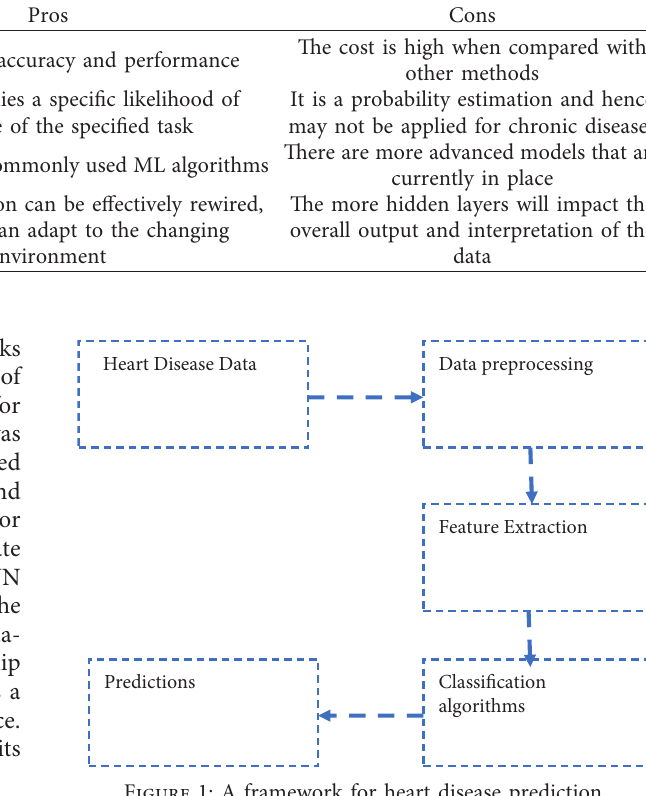
Table 1: Pros and cons from previous studies